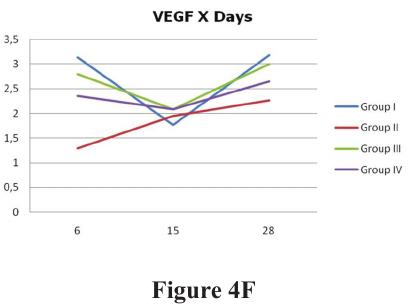
FIGuRE 4 - Molecular analysis. Expression of A ) RUNX2; B ) OCN; C ) ALP; d ) COL-I; E ) TNF-α; F ) VEGF, respectively, in each group in all periods.